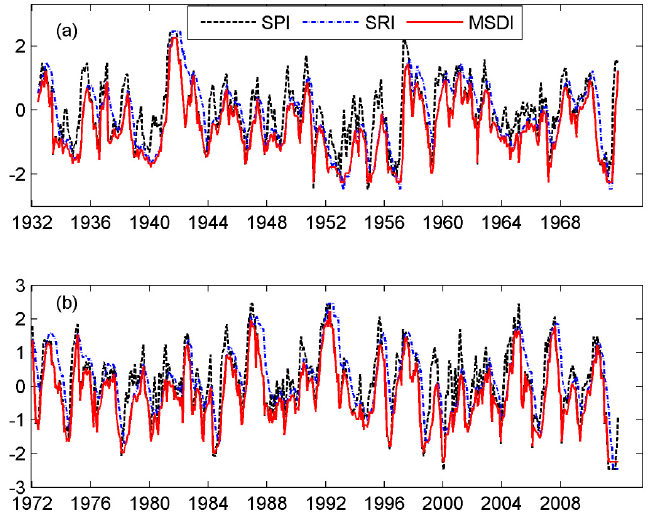
Figure 6. Comparison of drought condition based on SPI, SRI and MSDI in the bivariate case for the period from 1932-2011. ( a ) 1932–1971; ( b )